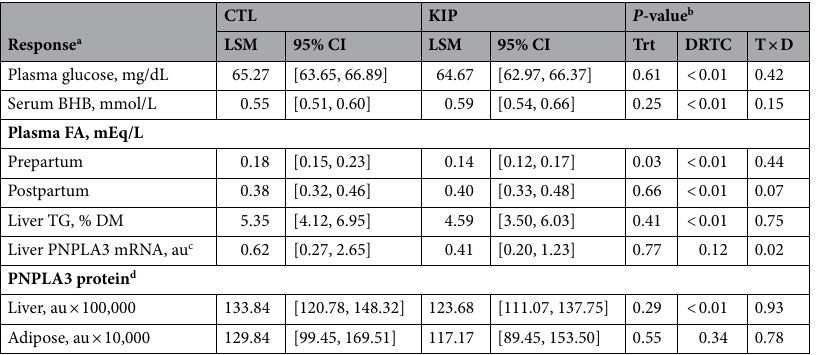
Table 2. Least squares means (LSM) and 95% confidence intervals (CI) of blood fraction metabolites, liver triglyceride (TG) content, and tissue patatin-like phospholipase domain-containing protein 3 (PNPLA3) expression for cows exposed to a control (CTL) or ketosis induction protocol (KIP) treatment. a β-hydroxybutyrate = BHB, FA = fatty acid, prepartum analysis included samples collected from − 28 to 0 expected days relative to calving, postpartum analysis included samples collected from + 1 to + 56 days relative to calving. b Statistics for fixed effects are treatment (TRT), day relative to calving (DRTC), and the interaction of TRT and DRTC (T × D). c Standard error of the mean for the transformed (1/x 0.5 ) PNPLA3 mRNA relative expression data was 0.29 and 0.28 for CTL and KIP cows, respectively. d Standard error of the mean Log 10 - transformed PNPLA3 protein abundance was 0.02 and 0.05 for liver and adipose tissue,